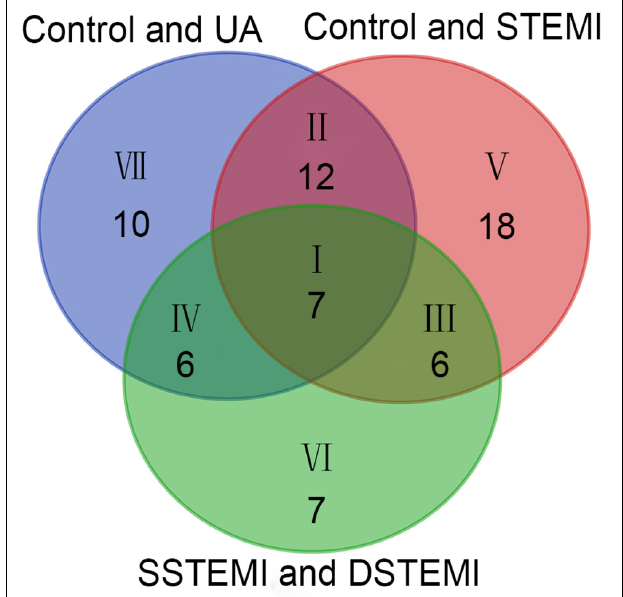
FIGURE 3 | Venn diagram of the metabolites identified from control vs. UA, control vs. STEMI, and SSTEMI vs. DSTEMI. DSTEMI, death group of ST-segment elevation myocardial infarction; SSTEMI, survival group of ST-segment elevation myocardial infarction; UA, unstable angina.